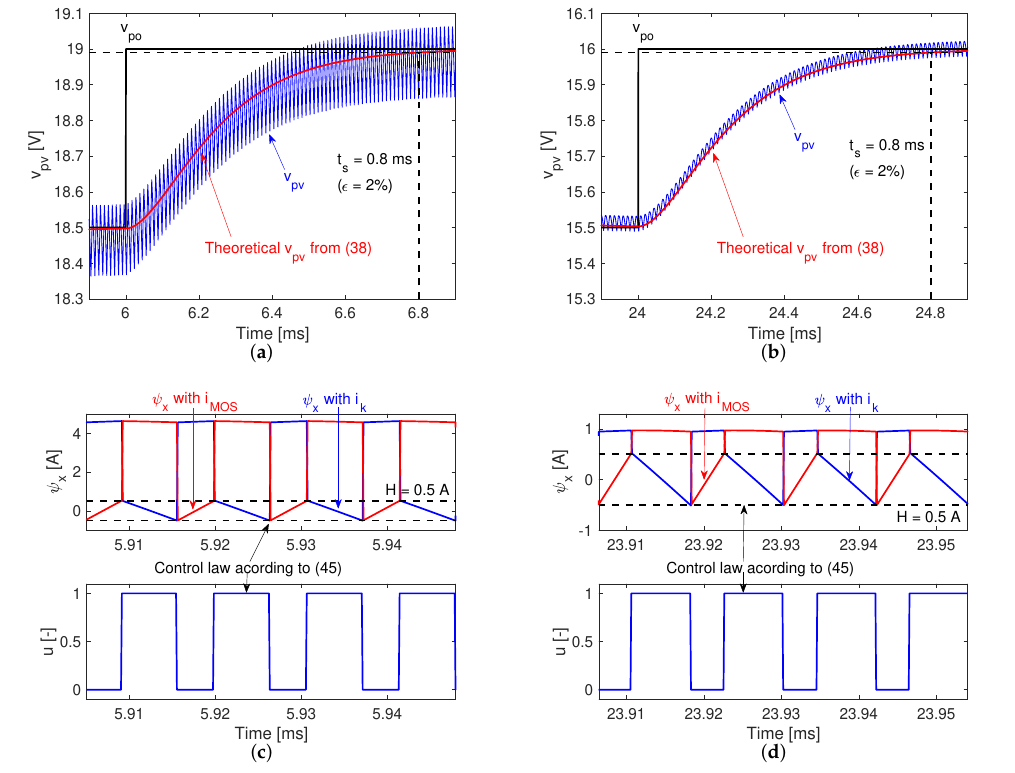
Figure 9. Circuital simulation of the PV system. ( a ) PV voltage response at high irradiance (1000 W/m 2 ). ( b ) PV voltage response at low irradiance (200 W/m 2 ). ( c ) Switching function and control law at high irradiance (1000 W/m 2 ). ( d ) Switching function and control law at low irradiance (200 W/m 2